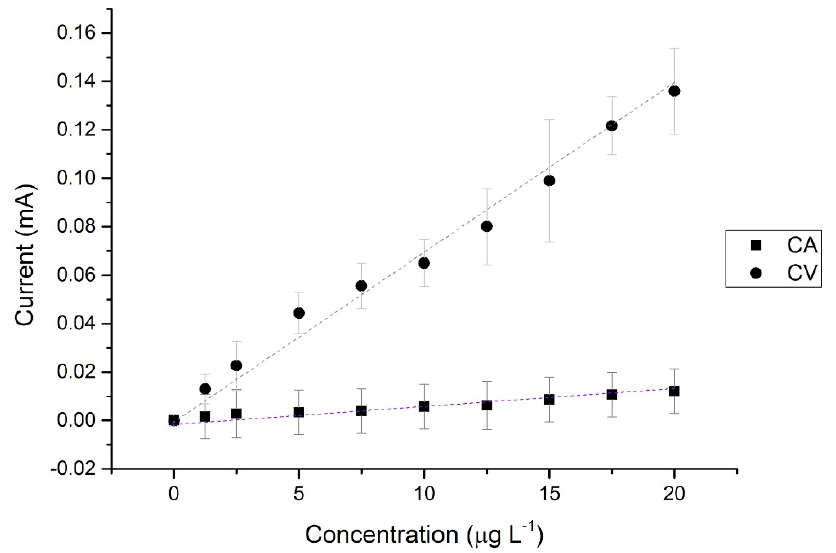
Figure 3. Calibration curves obtained by Cyclic Voltammetry (CV) and Chronoamperometry (CA). PBS:MeOH 1:1. Carbon SPE.